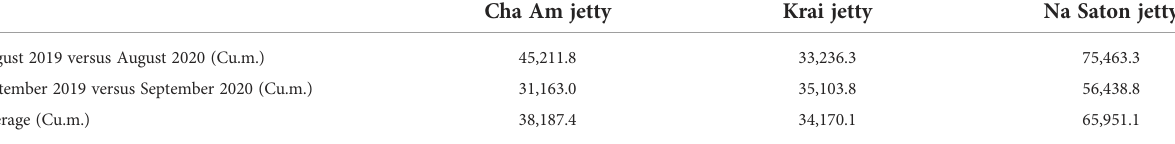
TABLE 5 Volumetric changes at the updrift jetties in this